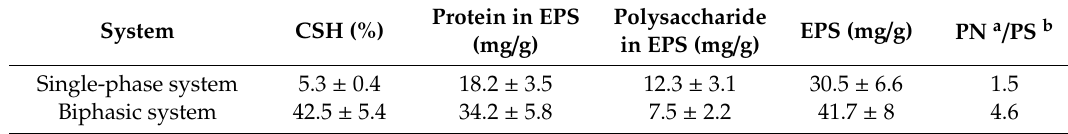
Table 2. CSH and EPS in the single-phase and biphasic systems (20% silicone oil).